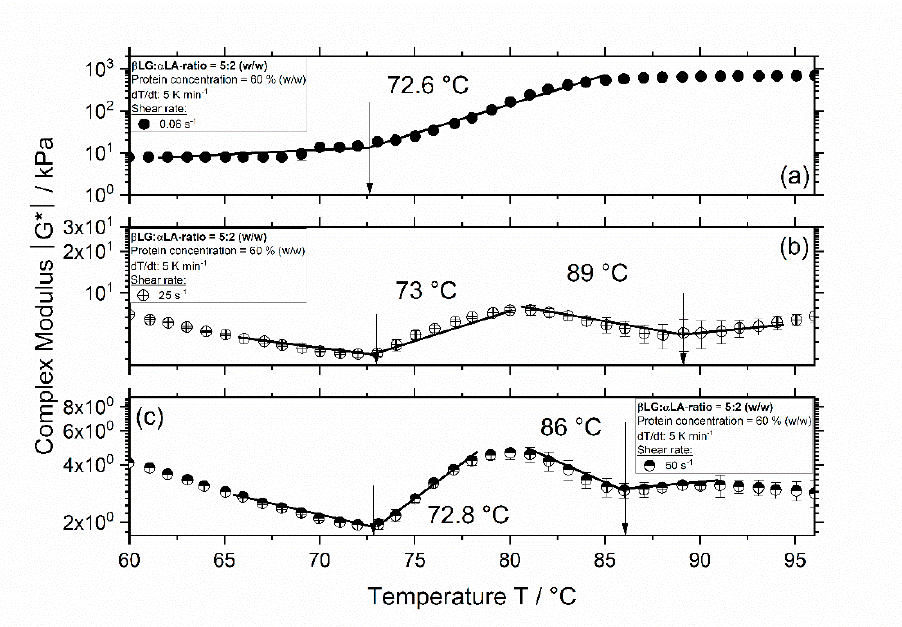
Figure 3. Complex modulus | G ∗ | as a function of temperature for 5:2 systems with a concentration of 60% ( w / w ) and a shear rate of 0.06 s − 1 ( a ), 25 s − 1 ( b ), and 50 s − 1 ( c ). Measurements were performed at a constant heating rate of 5 K min − 1 , bars represent standard deviation (SD).